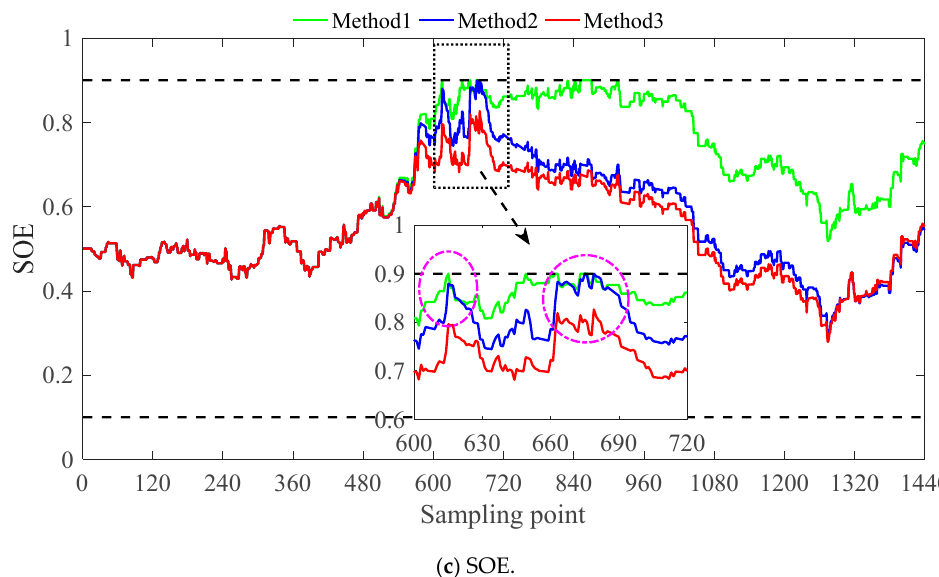
Figure 6. Curve of grid-connected power, grid-connected power fluctuation and SOE of the battery energy storage system (BESS) with different methods. ( a ) P G , ( b ) ∆ P G , and ( c ) SOE under Q = 2 MW, δ = 2.5 MW.